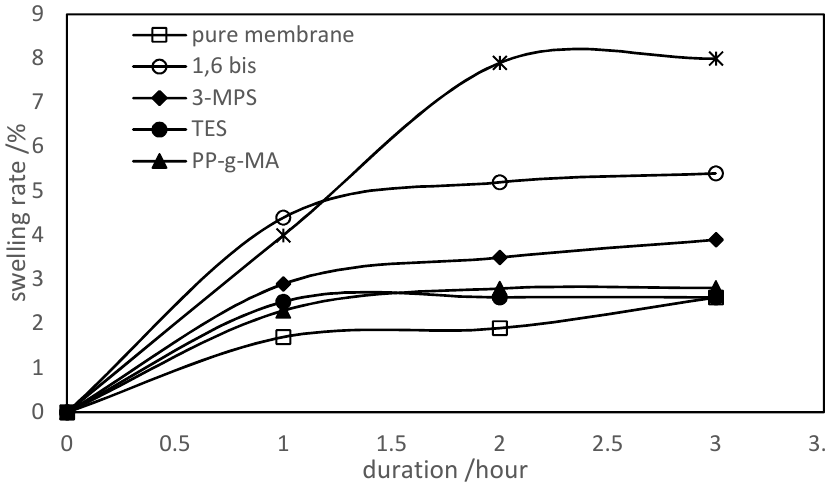
Figure 15. Swelling rate of composites with different modified GFs as functions of duration.